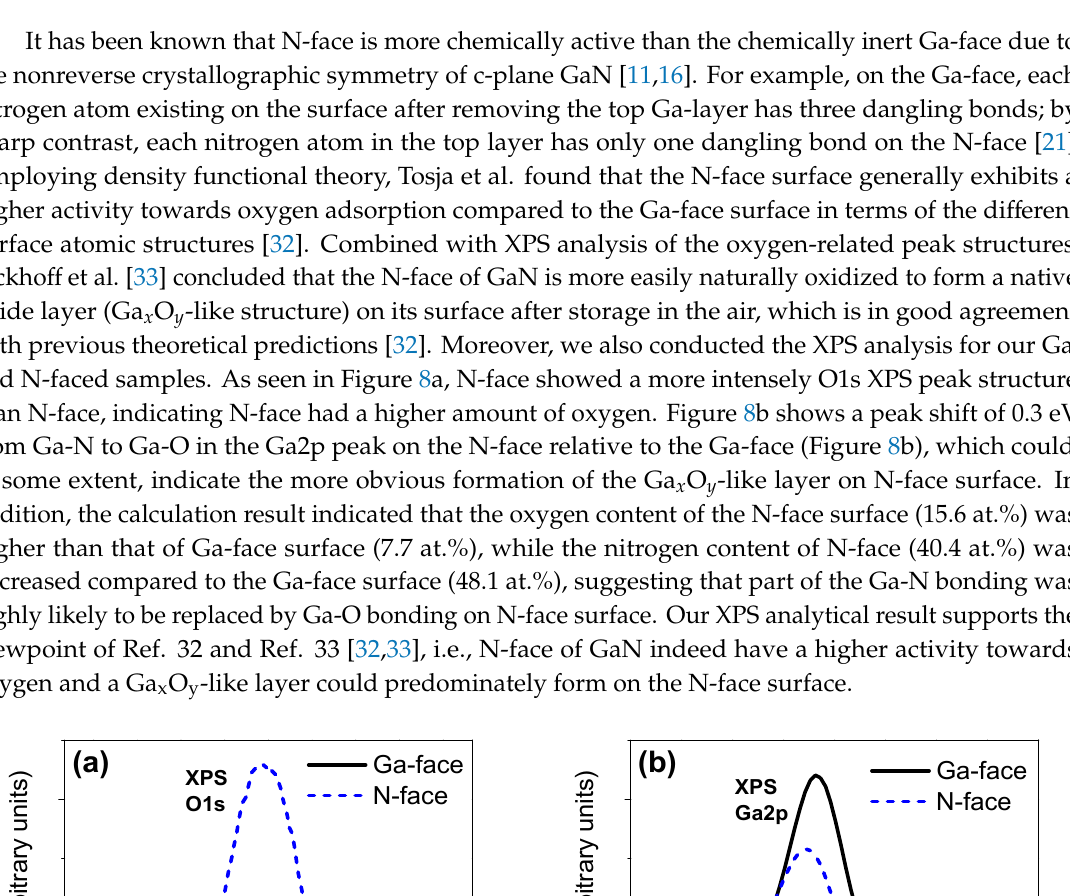
Figure 7. HRTEM images of the cross-section of Ga-faced GaN sample surface ( a ) and N-faced GaN sample surface ( b ). The cross-section was the (10 − 10) crystal plane of hexagonal wurtzite GaN.